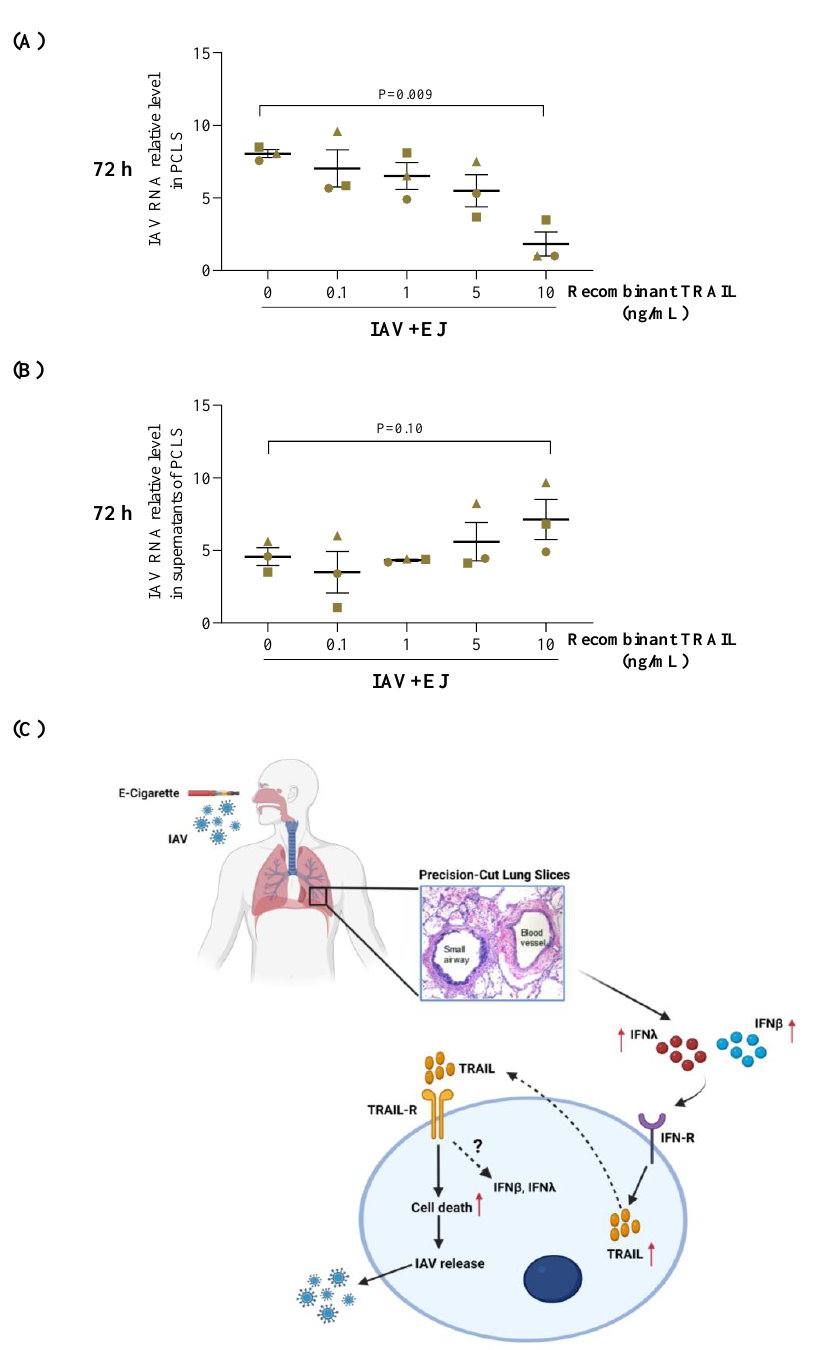
Figure 6. The dosing effect of recombinant TRAIL on viral infection in human precision-cut lung slices (PCLS) treated with E-juice (EJ) and influenza A virus (IAV). PCLS were treated with IAV and EJ in the presence or absence of BSA (control) and recombinant TRAIL (0.1–10 ng/mL) for 72 h. IAV load in tissue ( A ) and supernatants ( B ) was analyzed by RT-PCR. Each data point represents the individual replicate from a single donor. Horizontal lines indicate mean ± SEM. Paired t -test was used to analyze the data ( C ) Proposed mechanisms by which electronic cigarette (E-cig) exposures regulate IAV infection in human distal lungs. E-cig exposures amplify the expression of IFN- β and IFN- λ induced by IAV infection, which may upregulate TRAIL release. TRAIL binds to the TRAIL receptors to initiate cell apoptosis to enhance the release of IAV from the infected tissue. As a feedback loop mechanism, TRAIL may also upregulate the expression of IFN- β and IFN- λ to serve as an additional host defense